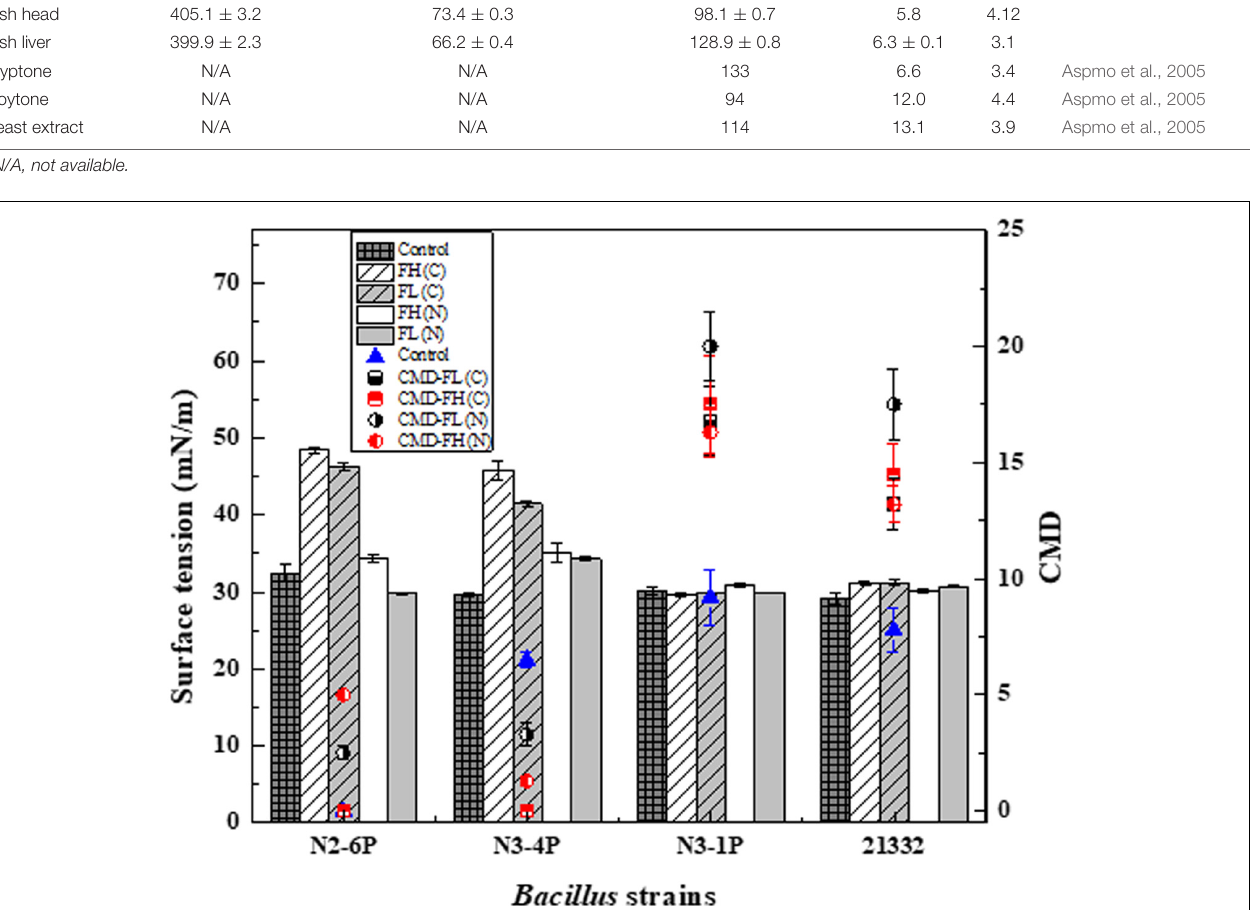
FIGURE 3 | Biosurfactant production in terms of surface tension (ST) and critical micellar dilution (CMD) of Bacillus subtilis N2-6P, N3-4P, N3-1P, and 21332 using fish head (FH) and fish liver (FL) peptones as carbon and nitrogen sources. Strains were inoculated at 2% concentration into three types of mineral medium. (1) Control: glycerol (10 g L - 1 ); NH 4 SO 4 (10 g L - 1 ) as carbon and nitrogen sources; (2) Fish peptones as carbon sources: glycerol were replaced by FH or FL at 10 g L - 1 [in terms of FH(C) and FL(C)]; and (3) Fish peptones as nitrogen sources: NH 4 SO 4 (10 g L - 1 ) was replaced by FH or FL at 10 g L - 1 [(in terms of FH(N) and FL(N)]. Strains were incubated at 30 ◦ C at 200 rpm for 7 days. Results are expressed as the average ± SD of three independent